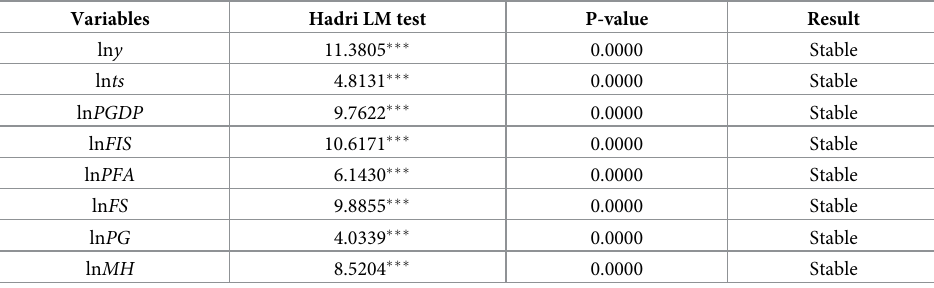
Table 2. Unit root test.